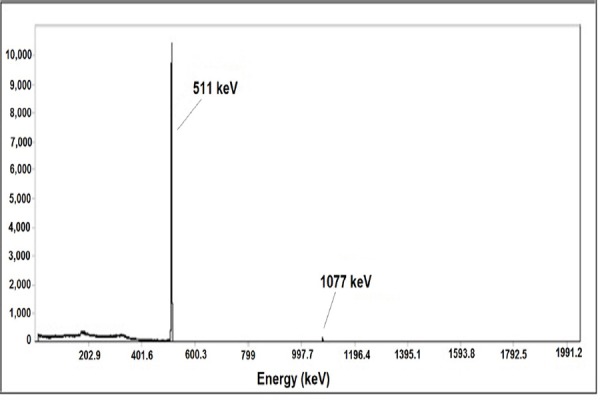
Gamma Spectrum of the eluted 68Ge after 48 h of the generator elution.